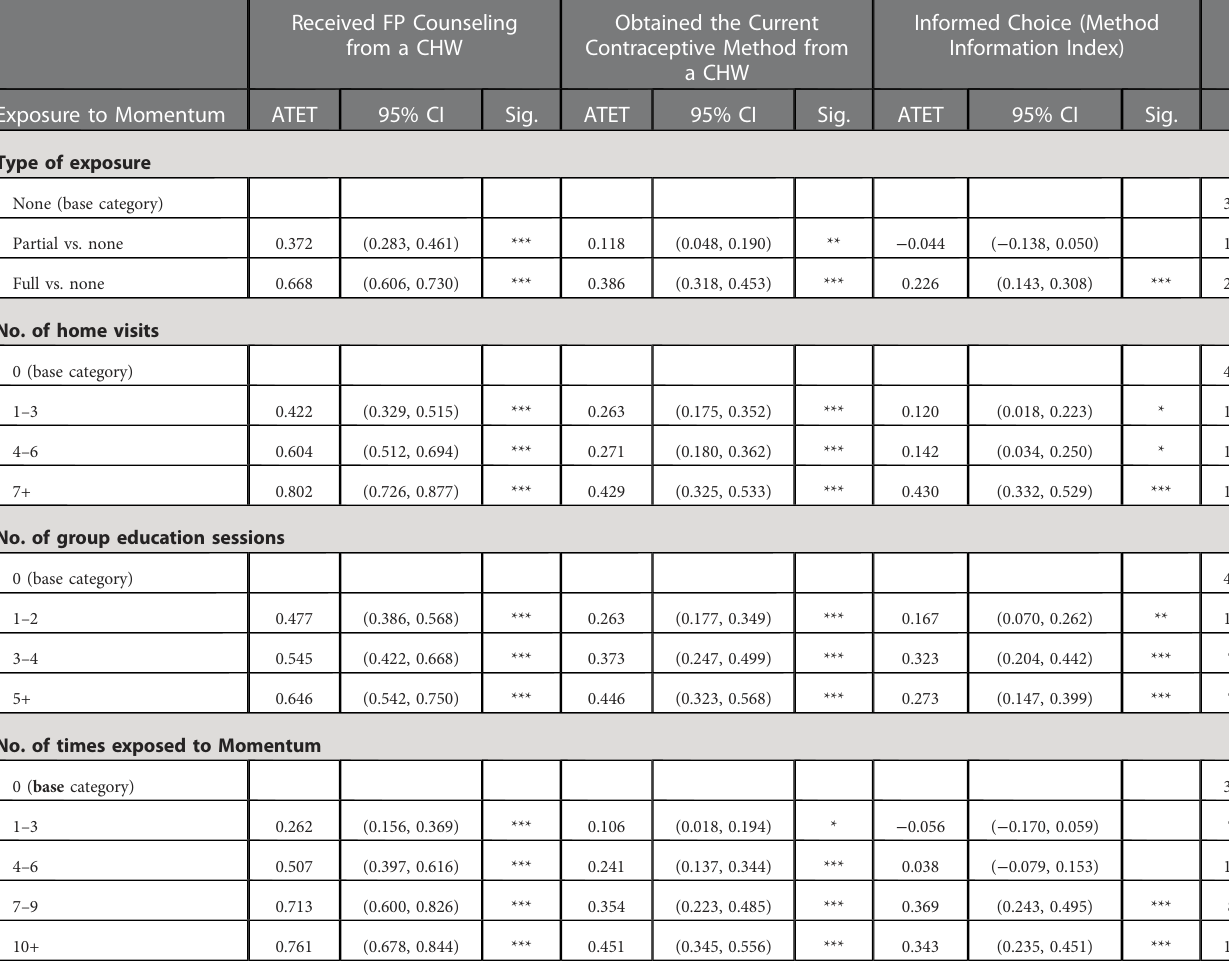
TABLE 4 Average treatment effects on the treated (ATET), 95% con fi dence intervals and p -values for selected outcomes by level of exposure to Momentum interventions, fi rst-time mothers age 15 – 24 who were currently using a modern method, Kinshasa. Received FP Counseling Obtained the Current from a CHW Contraceptive Method